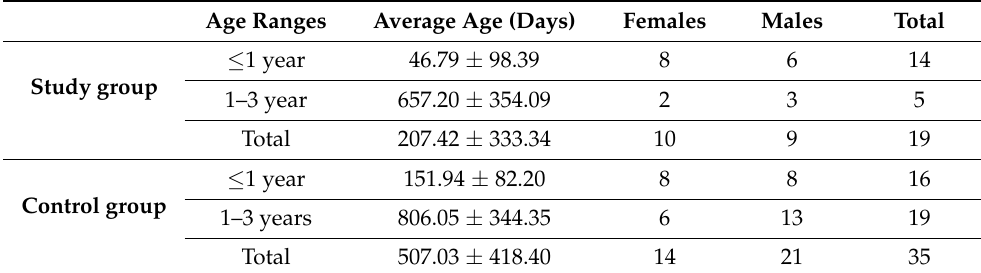
Table 1. Observed Population. Age Ranges Average Age (Days) Females Males Total Study